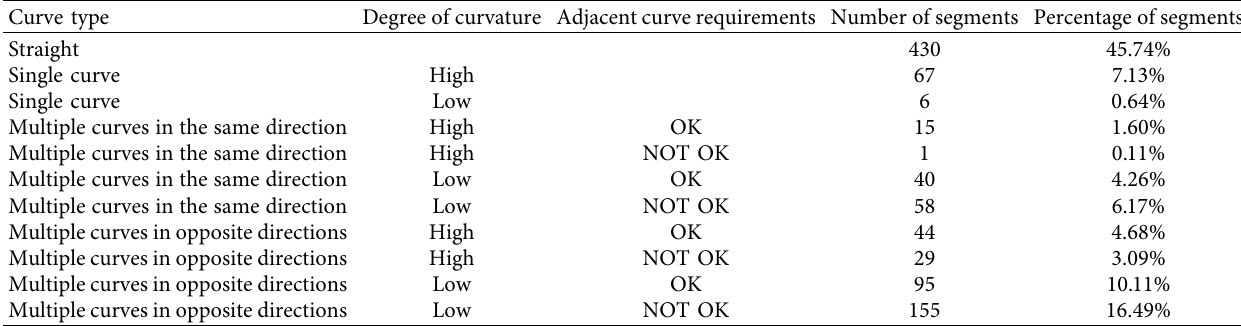
Table 4: Combinations describing the horizontal alignment in the statistical model.